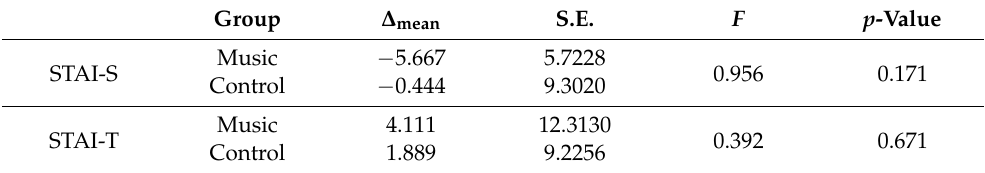
Table 5. State-Trait Anxiety Inventory: preoperative and postoperative differences. Group ∆